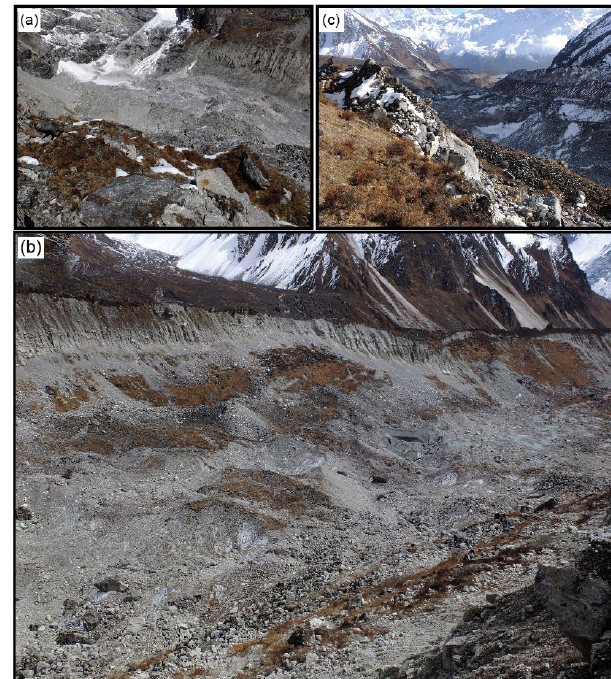
Figure 4. Field images of Lirung Glacier from the upper part (a) , where the rockwalls are still connected to the glacier, along the mid- dle disconnected part (b) to the lower glacier tongue (c) , where the decoupling is clearly visible. Also note the mass movements from the upper slopes (b) that do not reach the glacier.